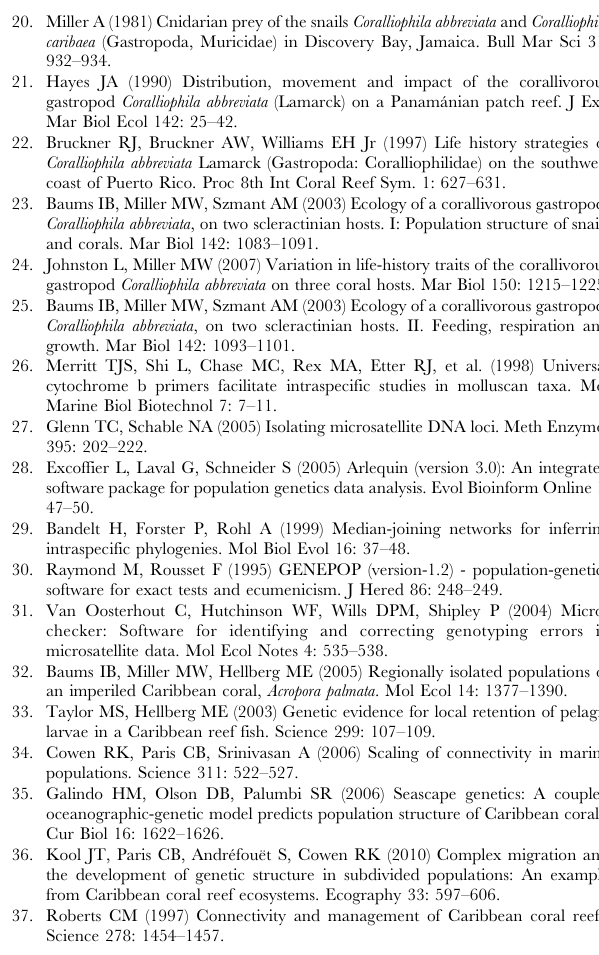
Table S1 Sample sizes of Coralliophila abbreviata by region, locality and reef for mitochondrial cyt b sequences (mtDNA) and microsatellite markers (Msats) with sampling coordinates. Table S2 AMOVA results for tests of geographic differentiation among sampled populations of Corallio- phila abbreviata . Figure S1 STRUCTURE plots representing the proba- bility of membership to each hypothetic population for 311 individual Coralliophila abbreviata based on five polymorphic microsatellite loci. Shown are plots for K = 2 (a), K =4 (b), and K= 10 (c), where individuals are grouped by